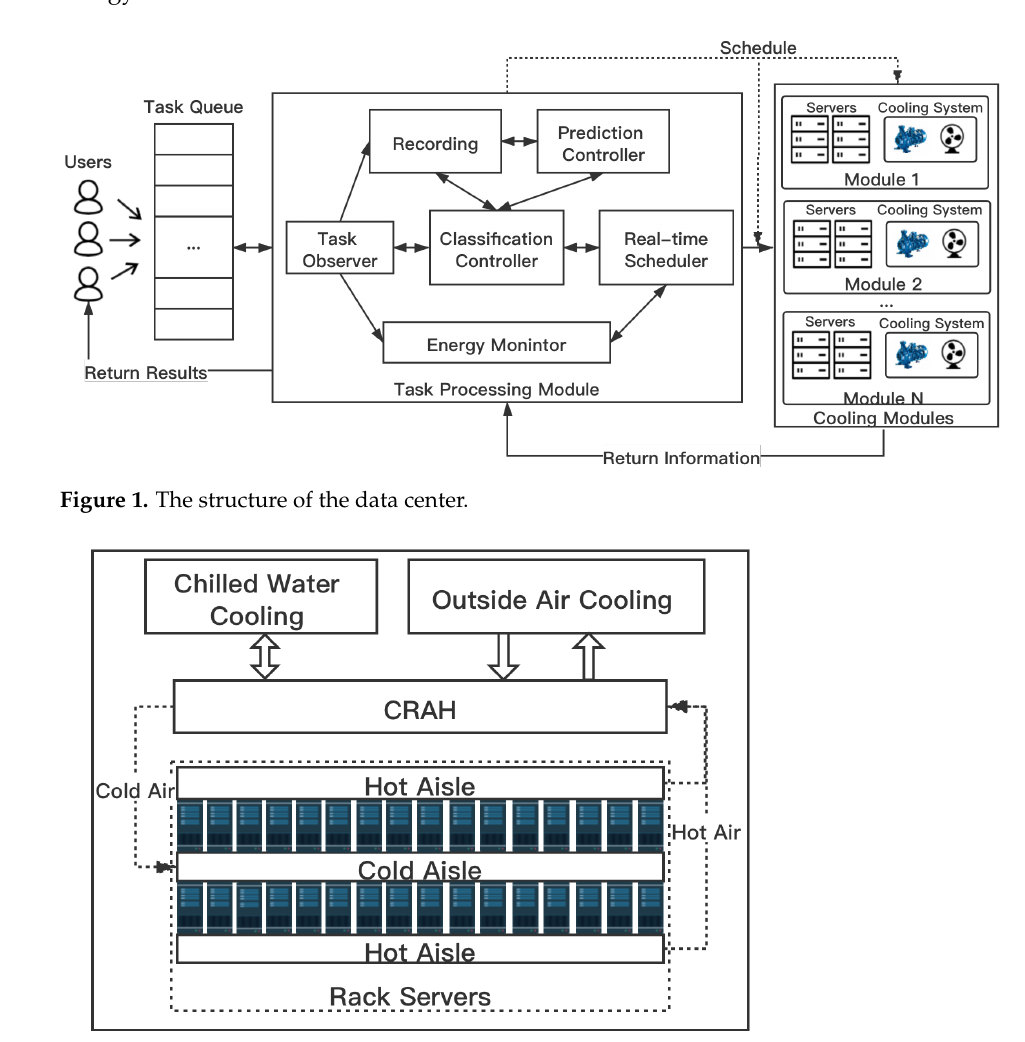
Figure 2. The structure of the cooling